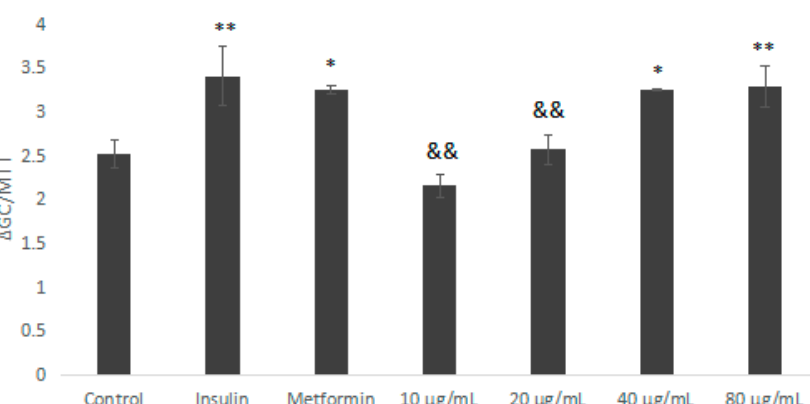
Figure 6. The impact of IOEP1 on the glucose uptake of HepG2 cells. Compared with the control group, * p < 0.05, ** p < 0.01; compared with the insulin group, && p < 0.01. GC—glucose concentration; MTT—3-(4,5-dimethyl-2-thiazolyl)-2,5-diphenyltertazolium bromide